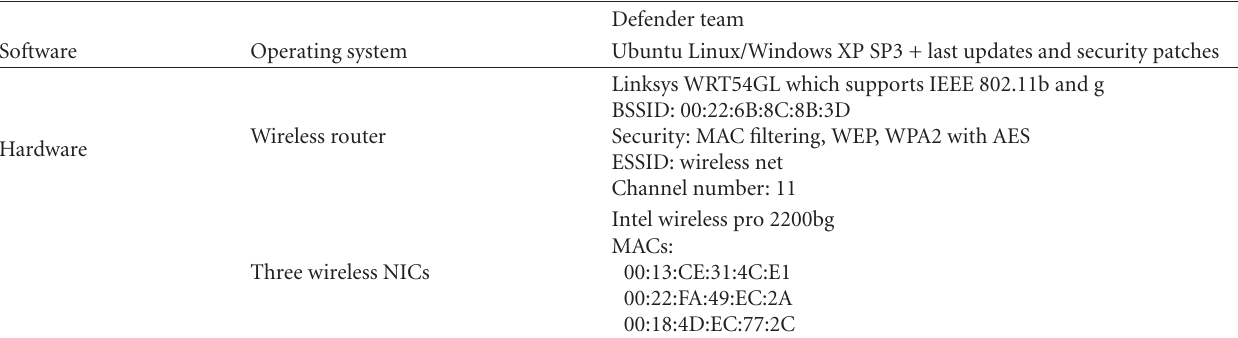
Figure 1: Laboratory environment for a pair team of the defender and the attacker. Table 1: Specification of the defender’s team